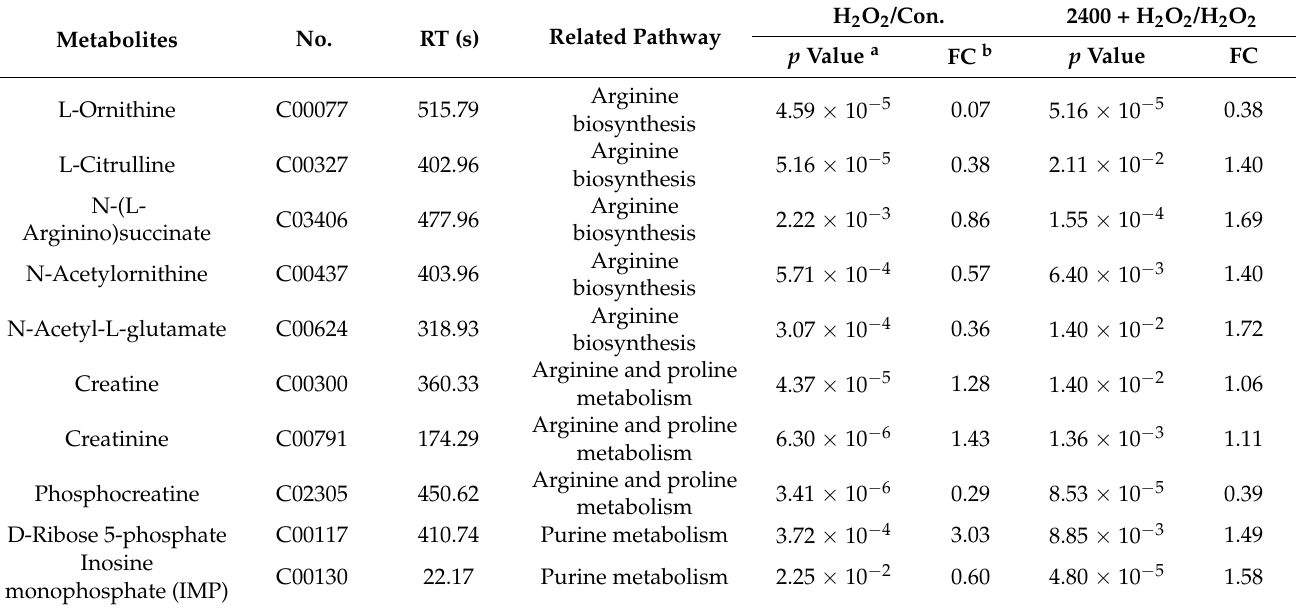
Table 1. Metabolites regulated by H 2 O 2 and chrysanthemum